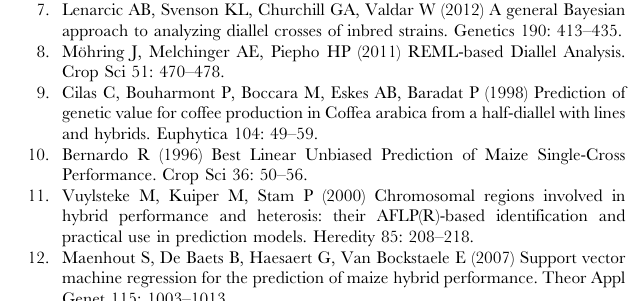
Figure S2 Class labels miss-classification frequency. The median miss-classification frequency for class labels (indicat- ing heterosis mode of action) of 69 metabolites showing balanced label sets obtained by SVM and compared against the minimum value obtained for permuted data sets (minperm). Metabolites are ordered according to the SVM misclassification rate for non- permuted data. Figure S3 Leave-one-out validation of feature ranking. Feature ranking in a LOO approach compared to the original rank position of the parental metabolites. In general, ranking order is preserved, which potentially allows to apply the model to novel genotypes not included in the model building process. Figure S4 Independence of metabolite levels. Metabolite levels cannot be regarded as independent from each other. In this example the hybrid level of metabolite X is dependent on the level of metabolite Y and can therefore not be predicted from the average parental value of X. Figure S5 Importance of maternal and paternal effects. Parental metabolic features can be ranked according to their importance in hybrid class label prediction. Low ranks indicate metabolites which often important in prediction models. Maternal parental features are overrepresented among the top 20 metab- olites from such a ranking. The Figure displays the number of maternal and paternal features up to a certain rank position. The further apart both lines are the stronger the effect is. At rank 20 for example we find 15 maternal and only 5 paternal metabolic features. Figure S6 Final model workflow. Model workflow to perform a feature selection based on mid-parent heterosis, ultimately allowing to predict HP from parental metabolic